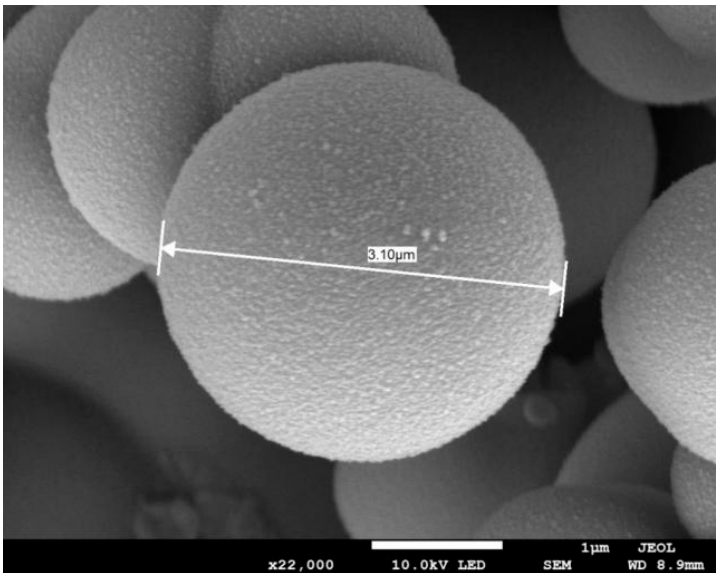
Figure 3. SEM micrograph from a microscale perspective.